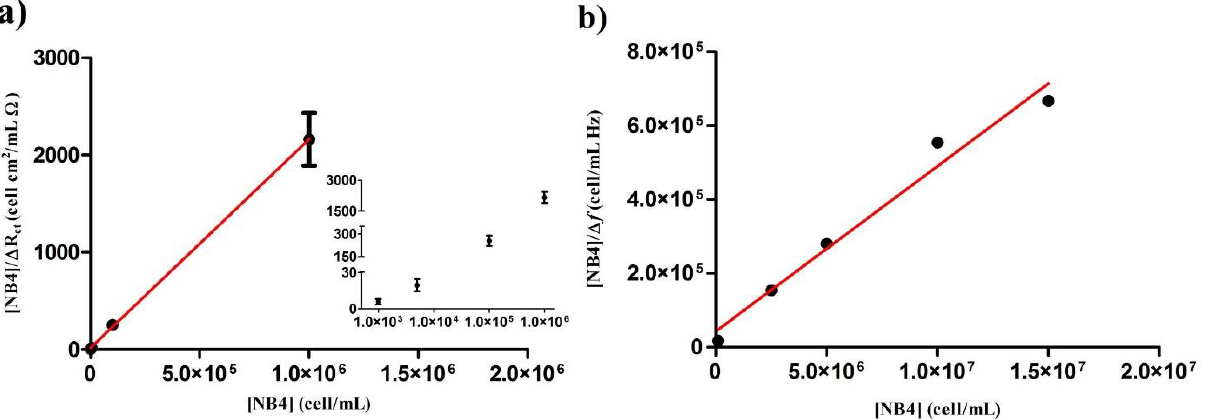
Figure 4. Linearized Langmuir isotherms for describing the ArtinM–NB4 interaction. The plots obtained by the EIS approach ( a ) and the QCM approach ( b ). The inset in ( a ) shows a log representation of cell concentration, R 2 = 0.99. In ( b ), the values of SD are smaller than the point size and are shown in Table 2 (R 2 =